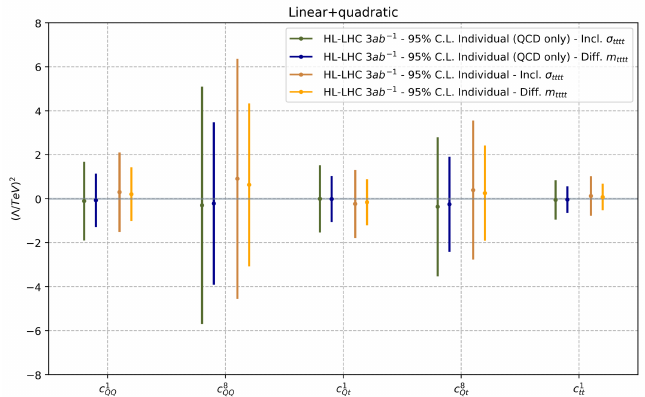
Figure 19 . 95%CL limits on the 4-heavy operators’ coefficients at the HL-LHC scenario from a χ 2 fit. The limits are shown for when only considering leading QCD terms and when considering all the terms, in using only inclusive information from σ tttt and when adding differential information from m tttt . EFT predictions were obtained for the linear and quadratic contributions.